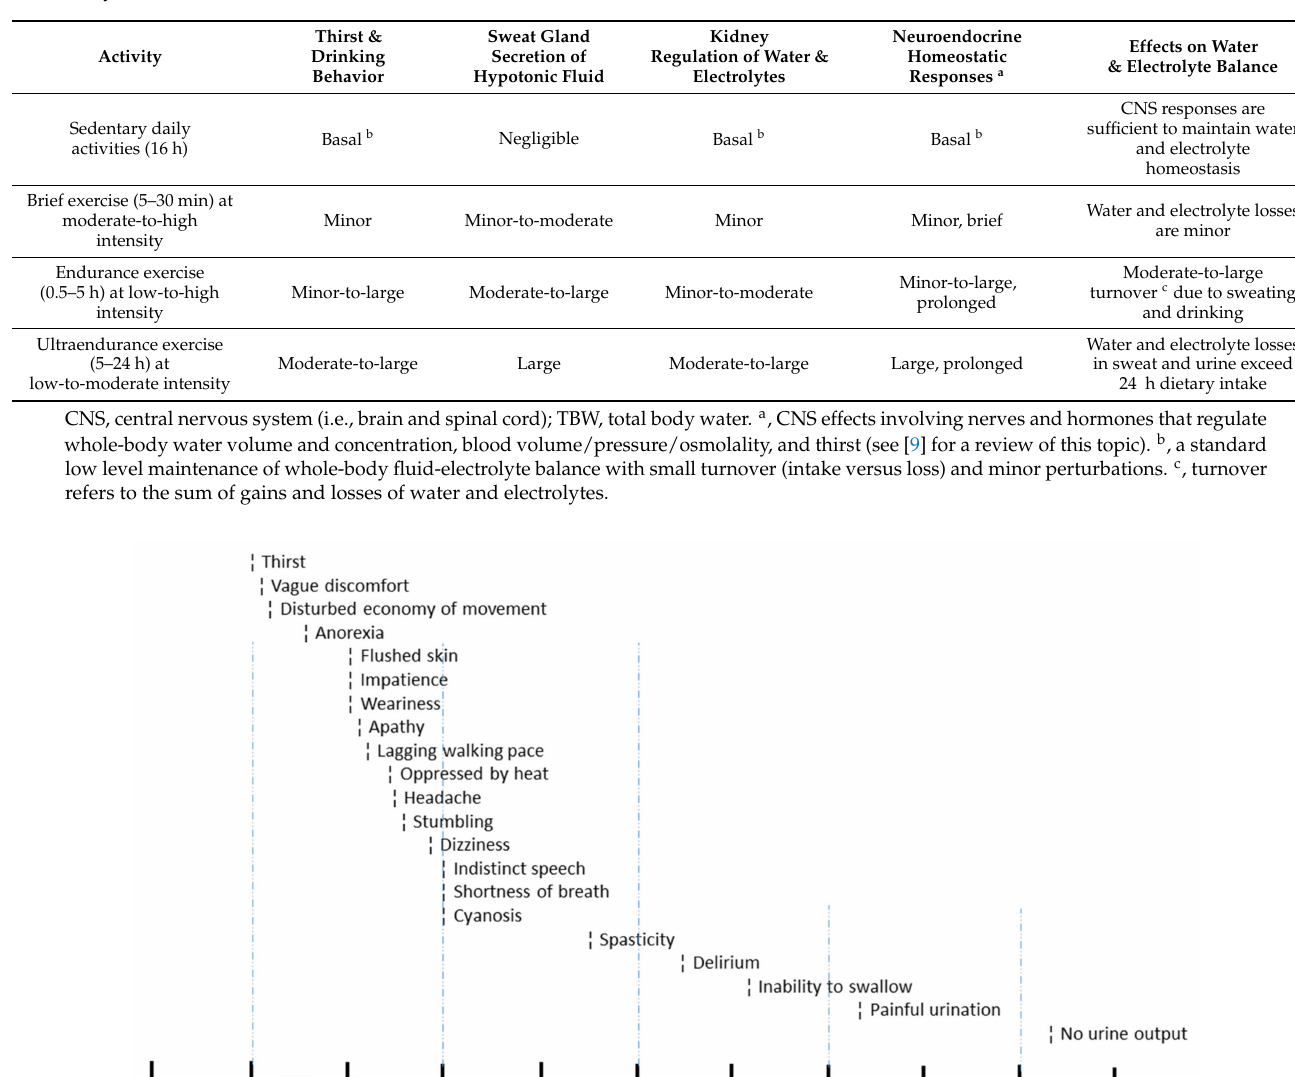
Table 1. The relative effects of thirst, drinking, and physiological responses on fluid-electrolyte balance during ordinary daily activities and endurance exercise.